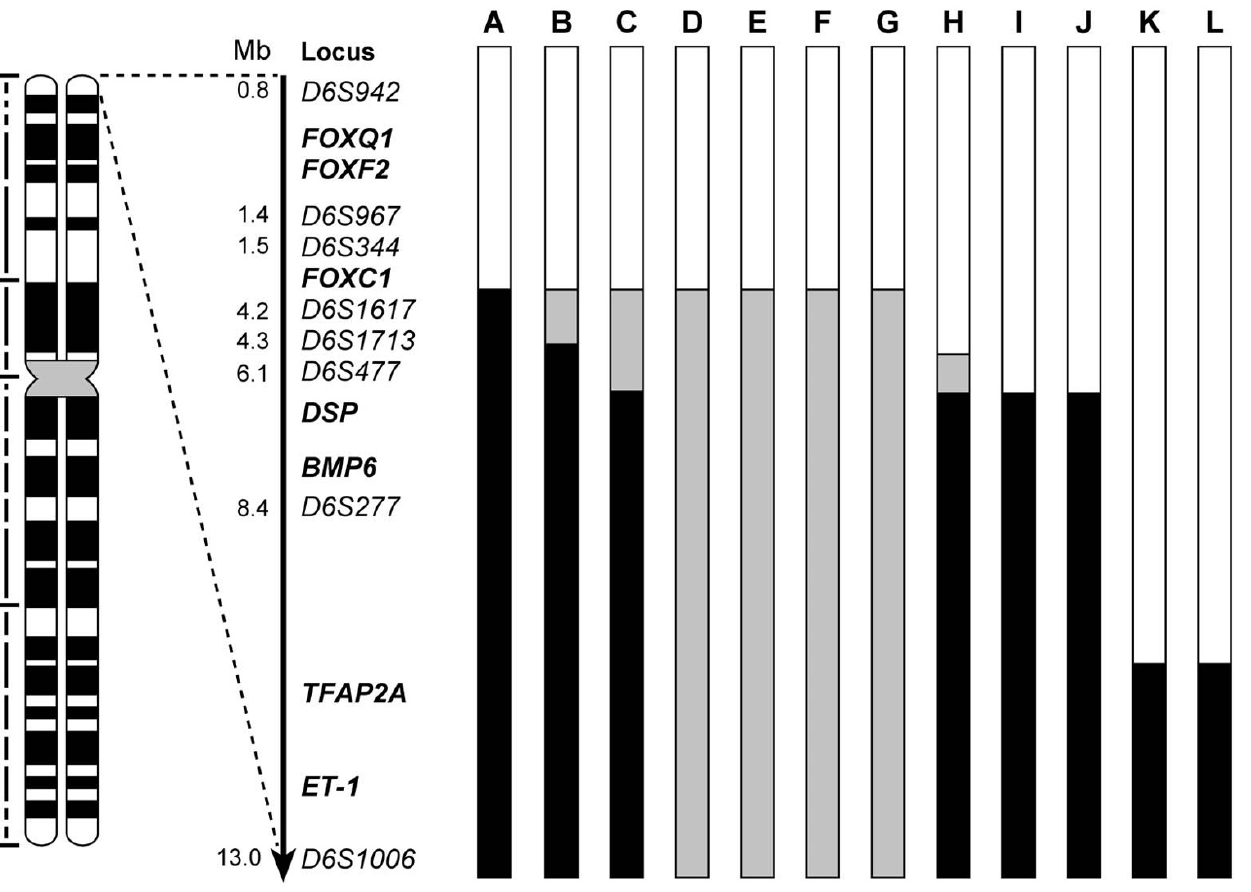
Figure 2 Schematic of extent of deletions for 12 patients in the literature with deletions characterized at a molecular level. The black boxes indicate regions where the patients are not deleted. White boxes indicate the minimum extent of the deletion. Grey boxes indicate markers that may or may not be deleted. Genes in this region are listed in bold print. The genetic distance of markers, in Mb (megabases) from the telomere, are also indicated. The source of the information is as follows: Patient A [19], Patient B [28], Patient C is case 2 from [25] and CA from 1, Patients D-G [18], Patient H [10] and SG from [1], Patient I is case 1 from [25] and BD from [1], Patient J is HH from [1], Patient K is JW from [1], Patient L is case 2 from